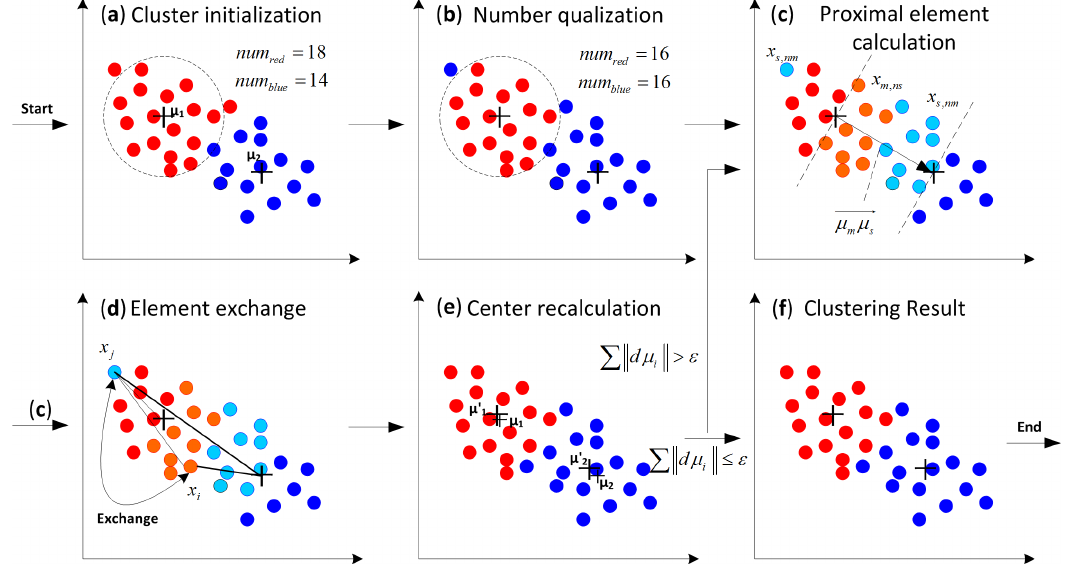
Figure 7. Main steps of equal-number clustering ( a ) Cluster initialization; ( b ) Element number equalization; ( c ) Proximal element determination; ( d ) Elements exchange; ( e ) Cluster center recalculation; ( f ) Result of the clustering